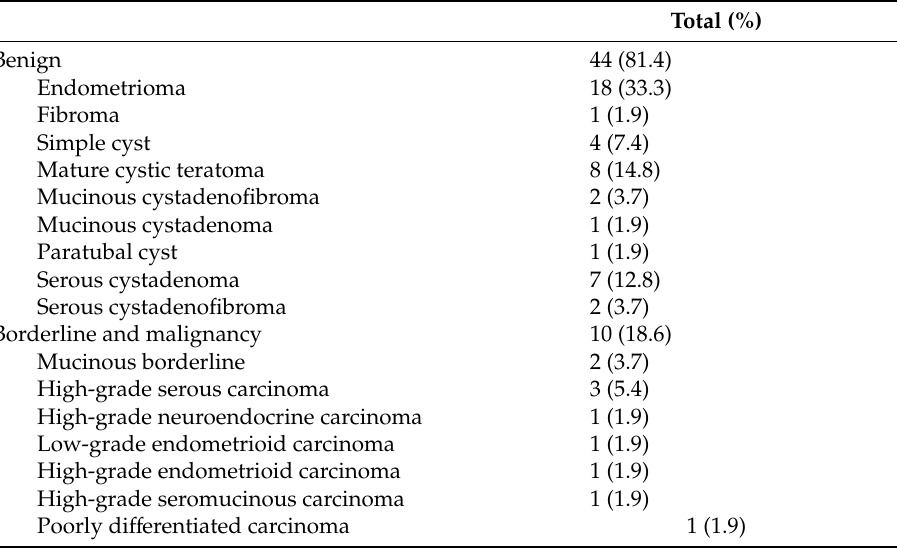
Table 2. Histologic diagnoses of surgical group ( n =